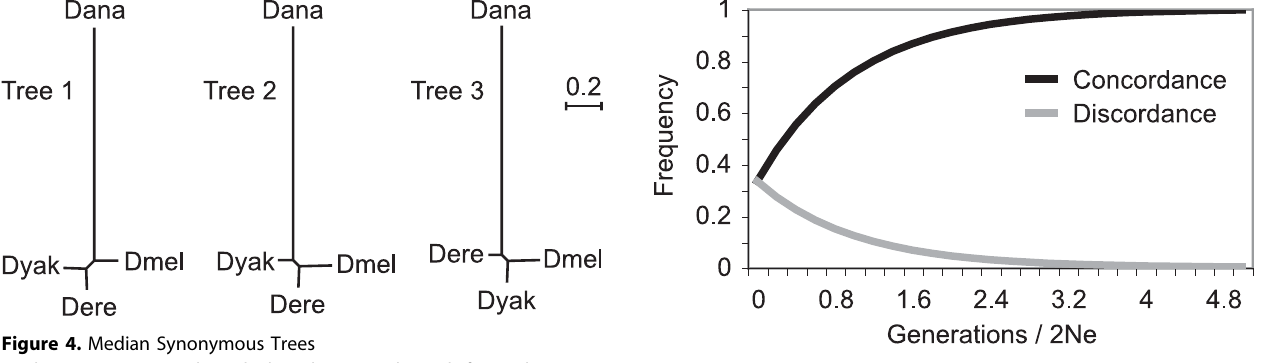
Figure 5. Coalescence Probabilities for Each Tree Using the formula p(congruence) ¼ 1 (cid:1) 2/3exp( (cid:1) t ), where t ¼ generations / 2Ne, the probability of the species tree (black) and the probability of one of the two alternate trees (gray) was plotted as a function of t . DOI: 10.1371/journal.pgen.0020173.g005